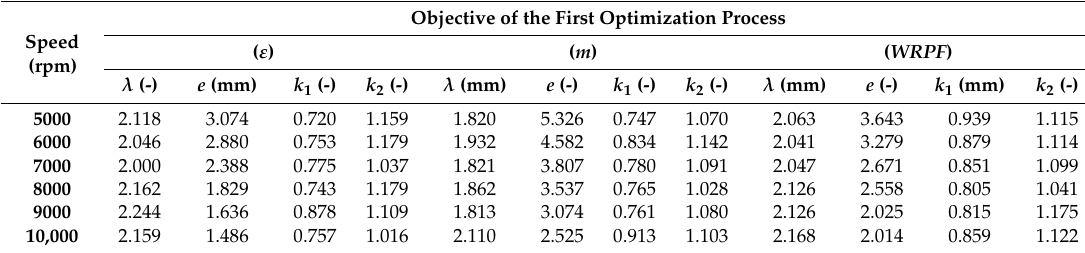
Table 1. Second-order optimization parameters.